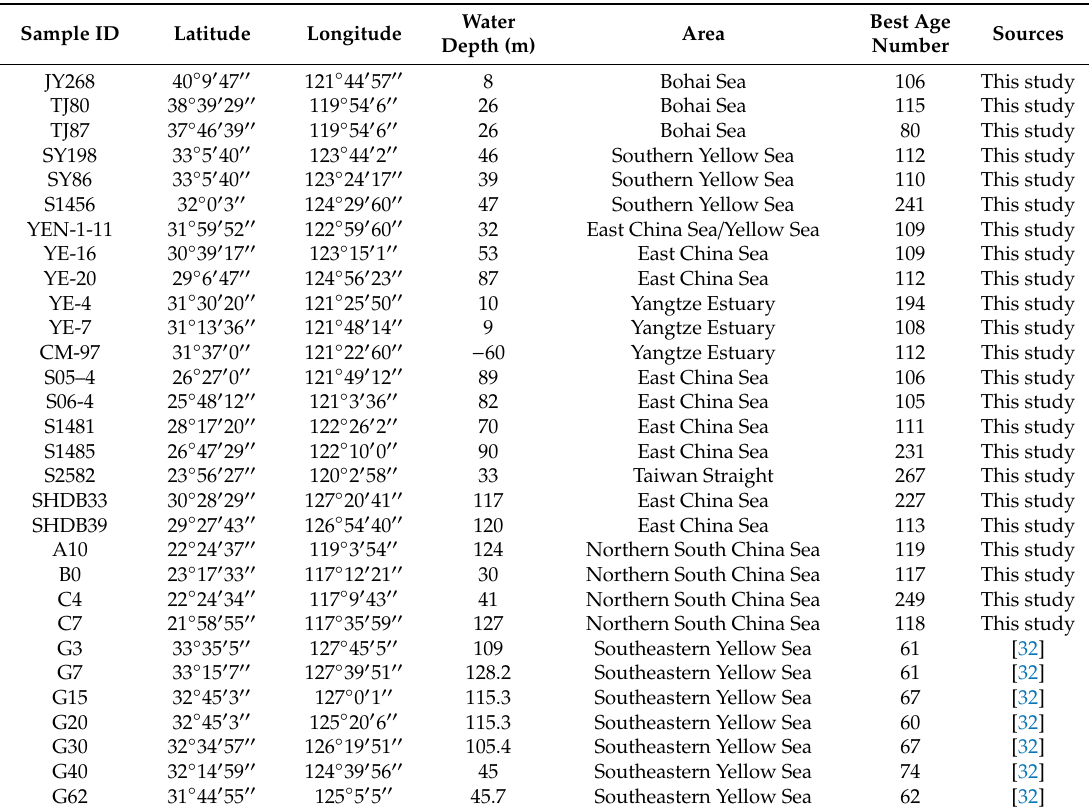
Table 1. Detrital U-Pb sample locations, water depths and the number of best U-Pb ages in the east China seas